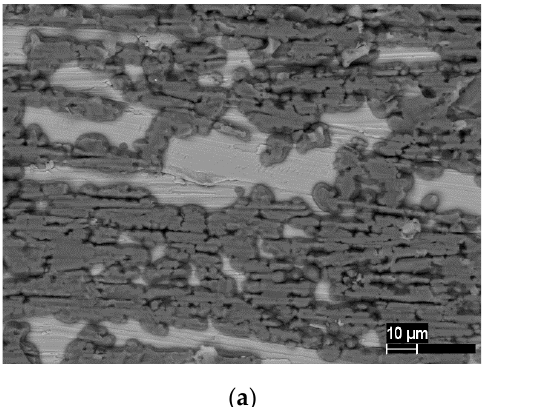
Figure 18. SEM images of the AISI 304/AISI 304 joint brazed according to the 540 °C/30 min mode. Different fracture views at 1000× magnification: ( a ) surface fractogram; ( b ) cross ‐ section.